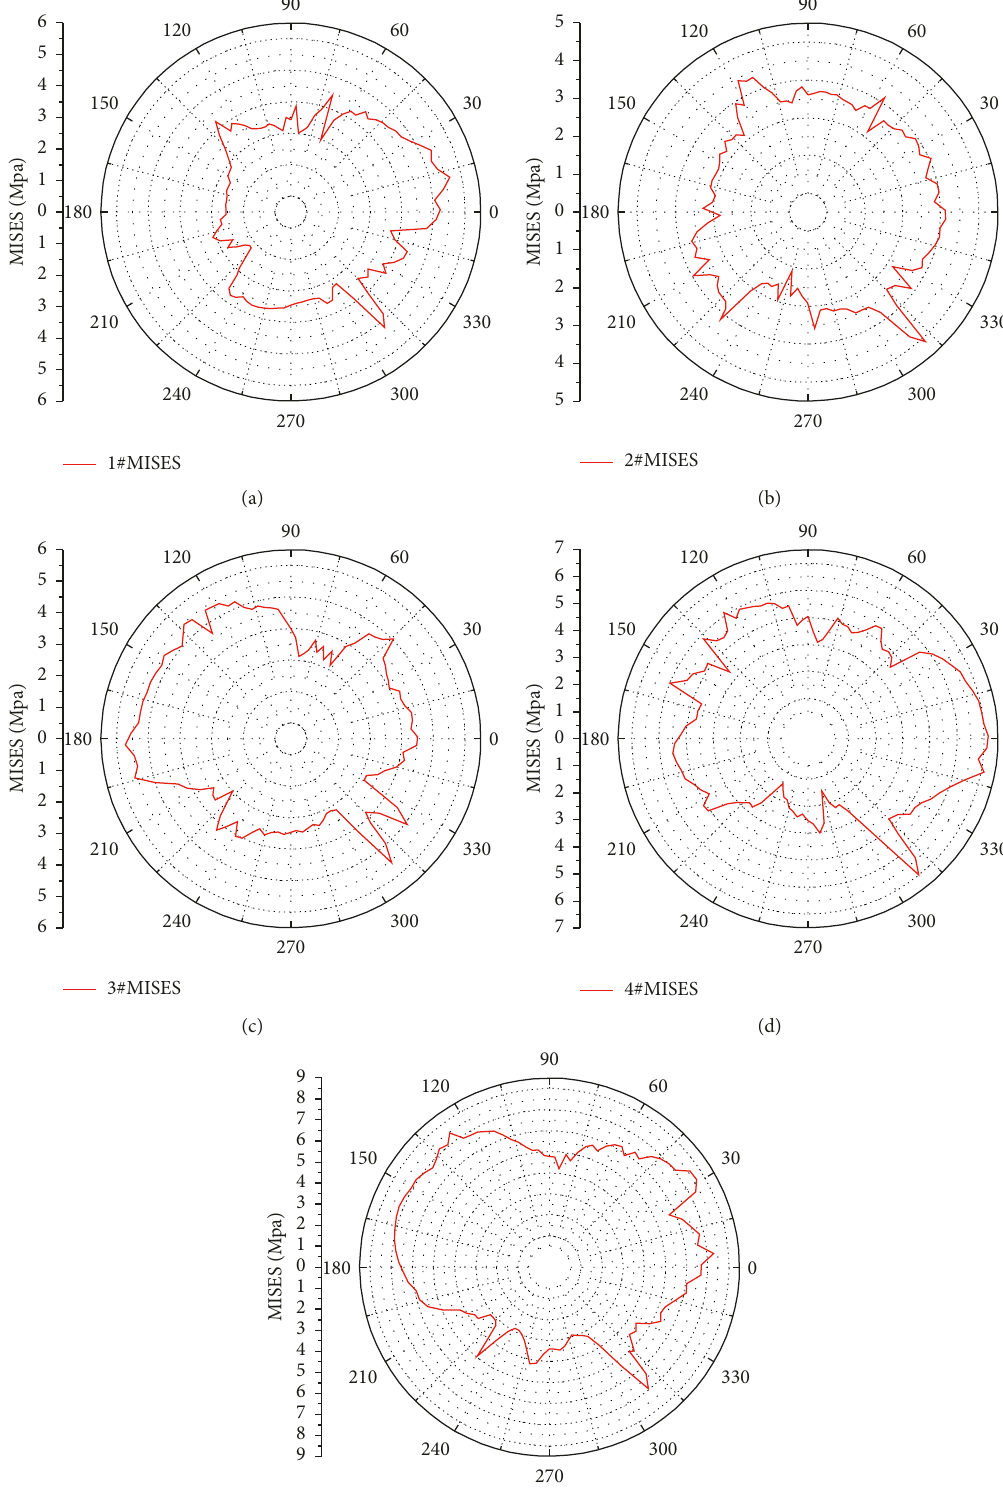
Figure 14: Polar coordinates of peak MISES stress in lining section. (a)–(e). (a) Peak MISES stress in section 1#. (b) Peak MISES stress in section 2#. (c) Peak MISES stress in section 3#. (d) Peak MISES stress in section 4#. (e) Peak MISES stress in section